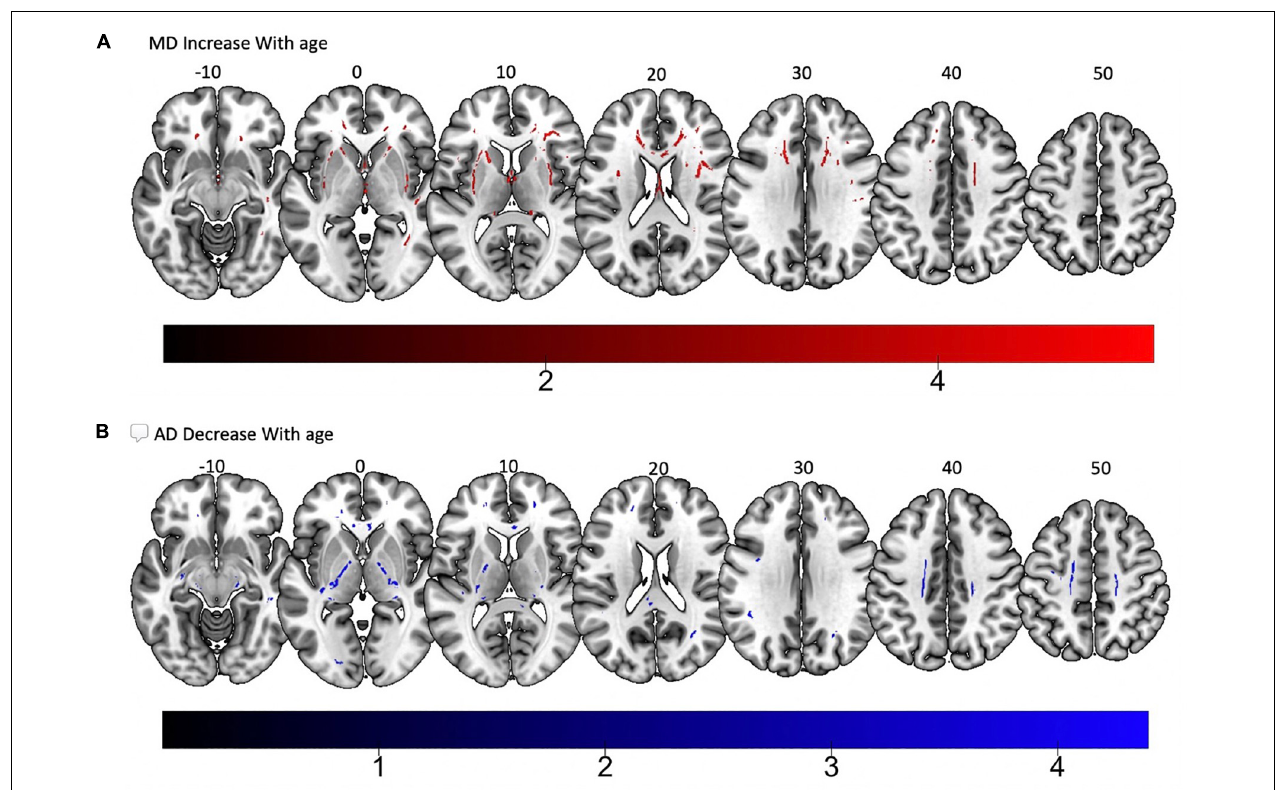
FIGURE 8 | Significant correlations between (A) MD increase with age and (B) AD decrease with age ( p < 0.05, cluster-wise FDR corrected for multiple comparisons). Pictures are in neurological convention with left side in the figure corresponding to the left side of the